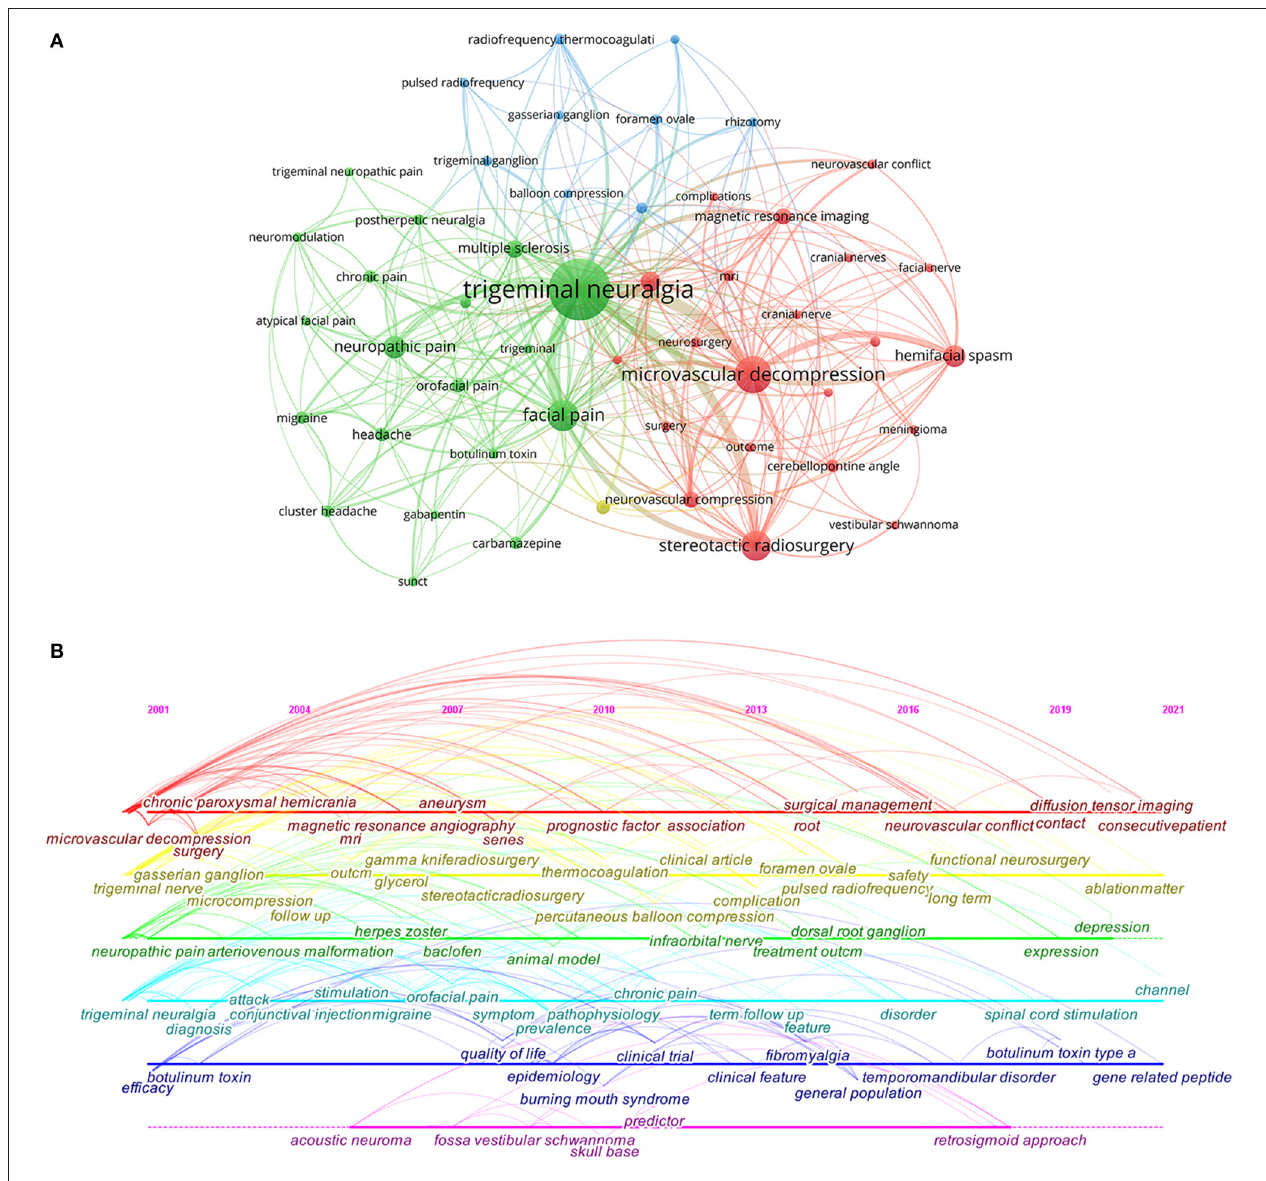
FIGURE 5 | (A) The co-citation network visualization map of keywords on TN research between 2001 and 2021. (B) A CiteSpace visualization map of timeline viewer related to